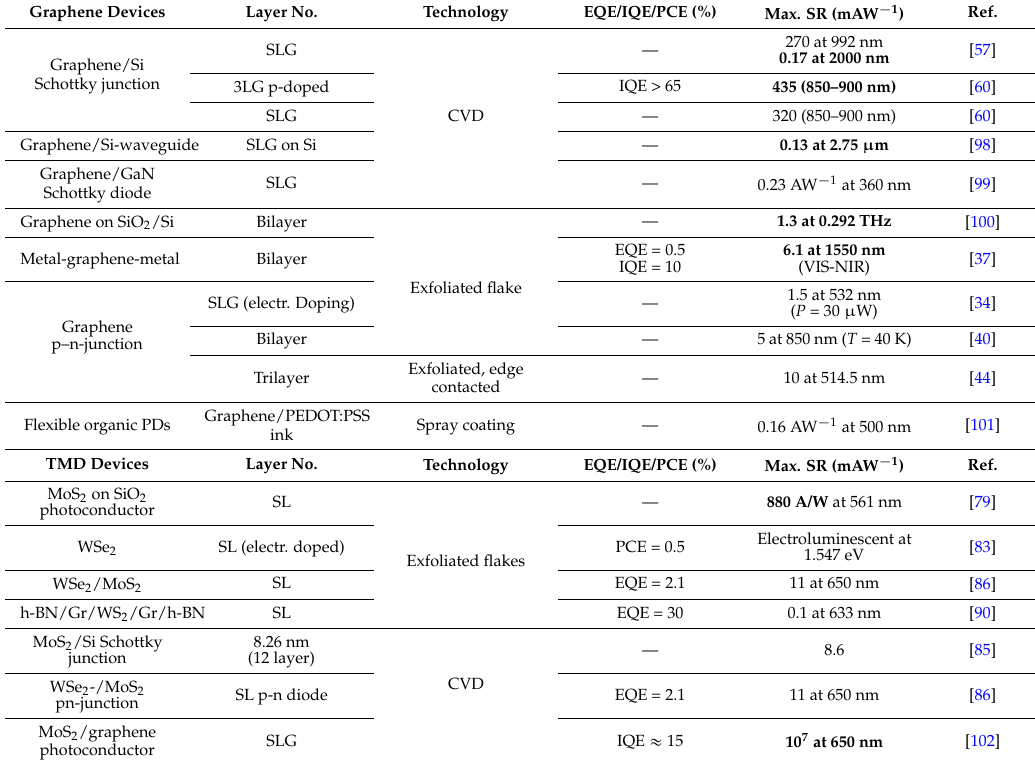
Table 1. Summary of literature data for 2D material-based photonic devices. The table contains the layer thickness, 2D material fabrication technology and electro-/optical benchmark parameters (external quantum efficiency (EQE), internal quantum efficiency (IQE), photo conversion efficiency (PCE) and spectral response (SR)), where reported. SLG, single-layer graphene. Graphene